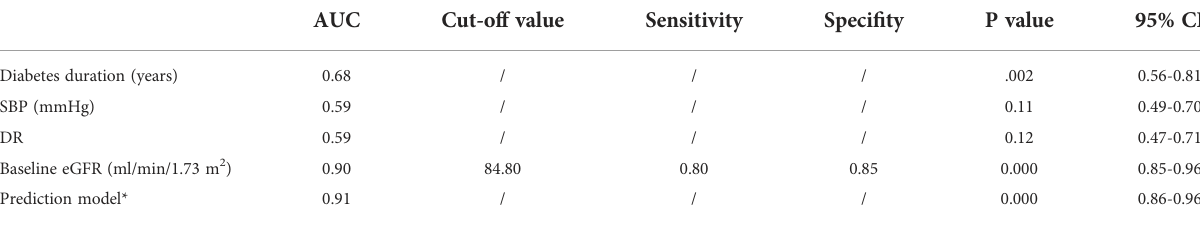
TABLE 4 Sensitivity, speci fi city and youden index of the eGFR at different cut-off values. AUC